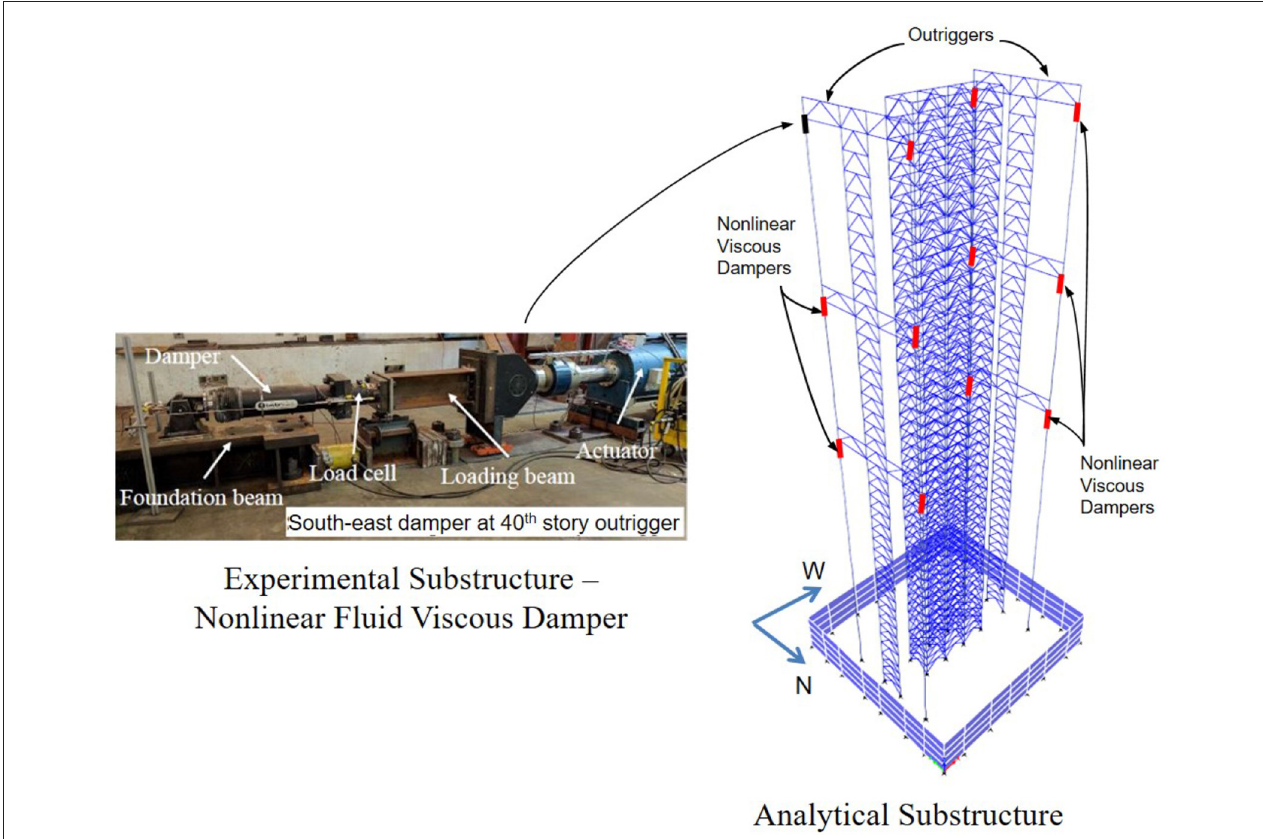
FIGURE 9 | RTHS of a tall building equipped with a damped outriggers system; numerically and physically modeled dampers are marked in red and black,